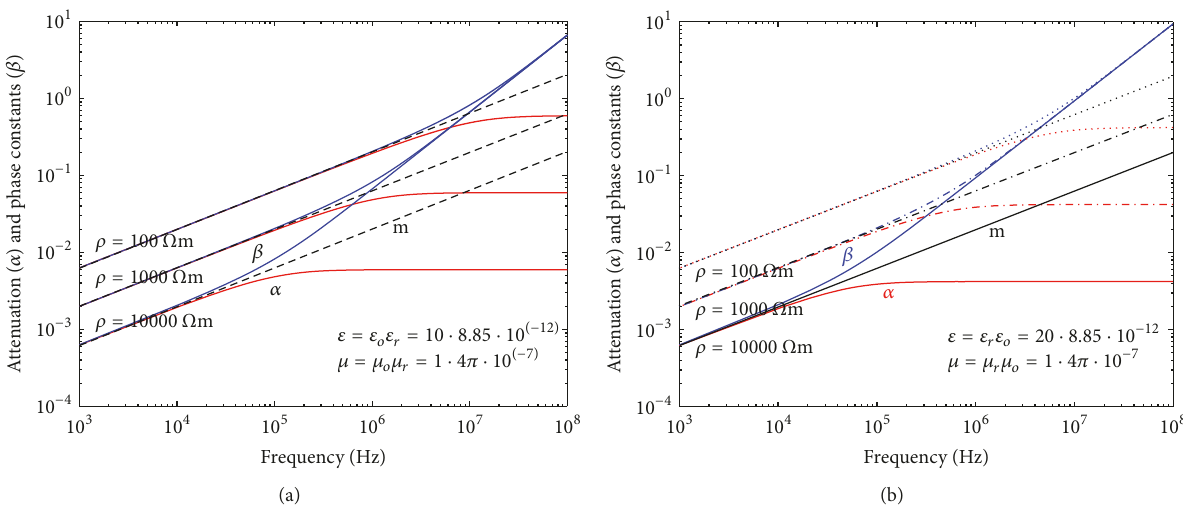
Figure 2: (a) The attenuation ( 𝛼 ) and phase ( 𝛽 ) constants in a dissipative medium with 𝜀 𝑟 = 10 and 𝜌 = 100, 1000, and 10000 Ω m. (b) The phase and attenuation constants in a dissipative medium with 𝜀 𝑟 = 20 . 𝛼 is the attenuation (red lines) as Nepers/m and 𝛽 is the phase constant (blue lines) as rad/m. The m-curve is valid when the attenuation constant equals the phase constant or 𝛼 ≈ 𝛽 (black curves).